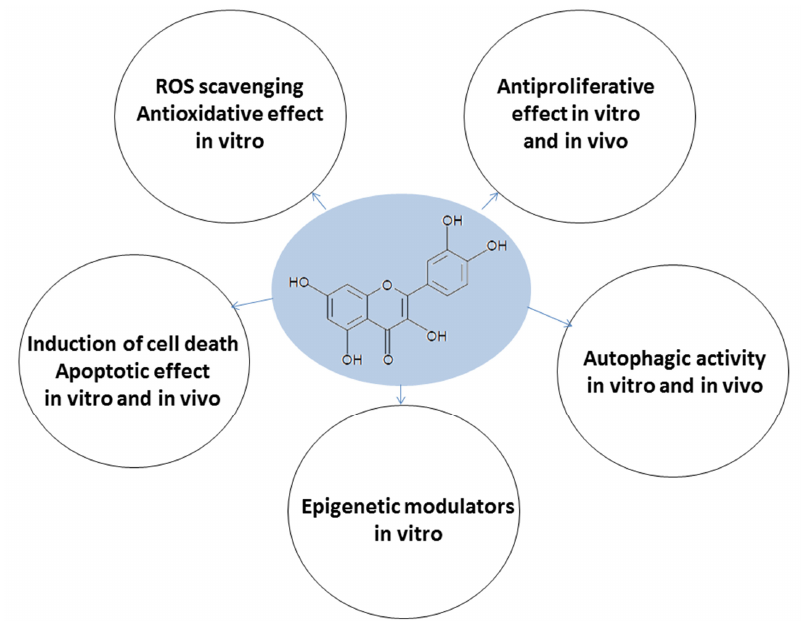
Figure 5. Multitarget effects of quercetin on acute myeloid leukemia and myelodysplastic syndrome.